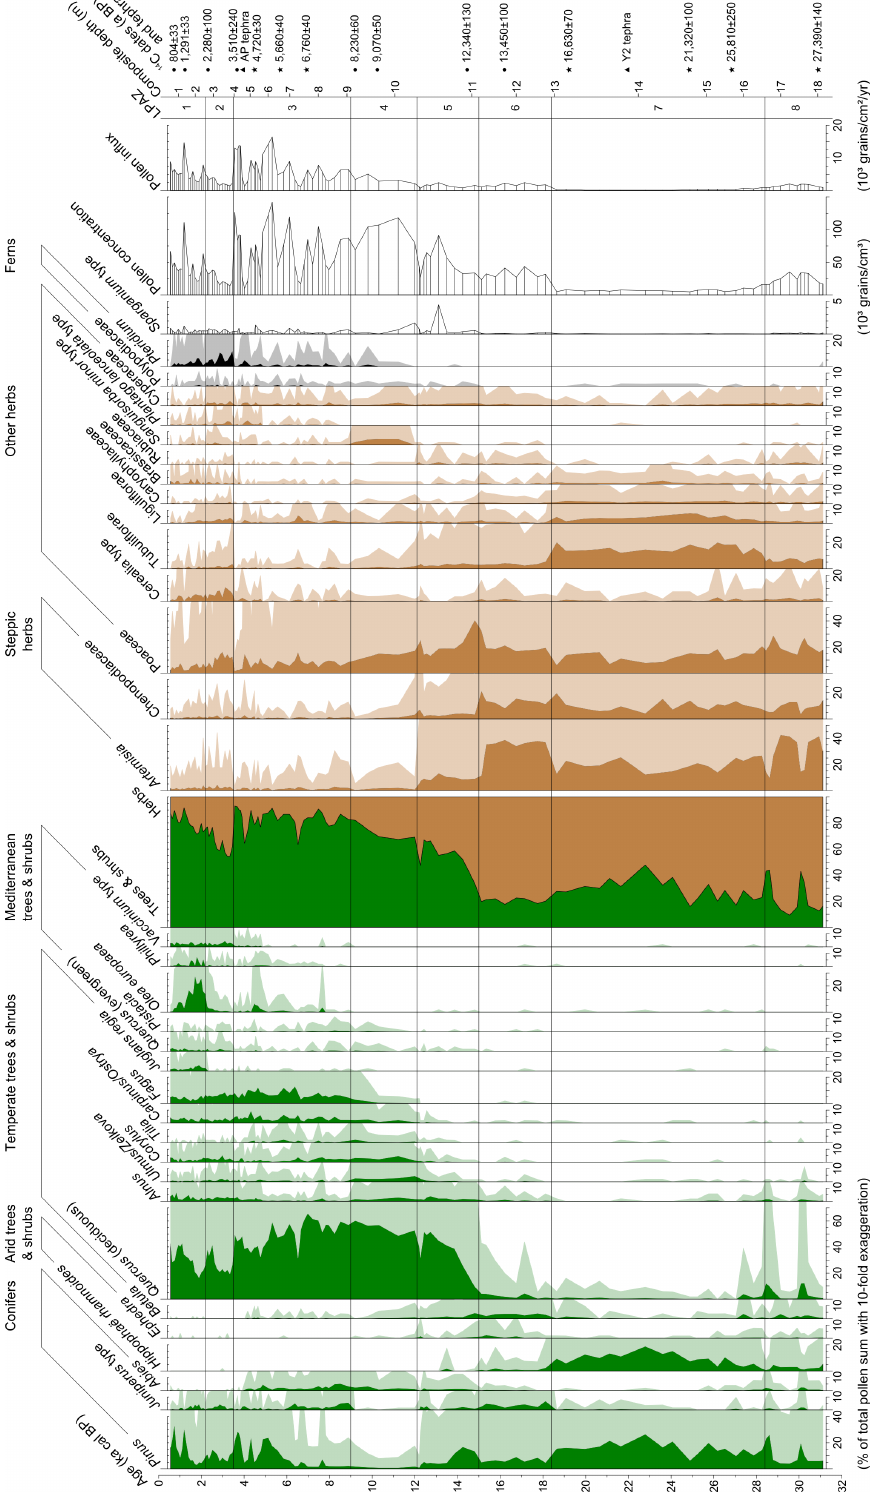
Figure 4. Pollen diagram inferred from Lake Iznik sediments with selected terrestrial plants in percentages, selected aquatic plants in con- centrations, total pollen concentrations, total pollen influxes (pollen accumulations), and local pollen assemblage zones (LPAZ). Radiocarbon dates from plant remains (circles) and bulk organic (stars) as well as tephra positions according to Ülgen et al. (2012) and Roeser (2014) are